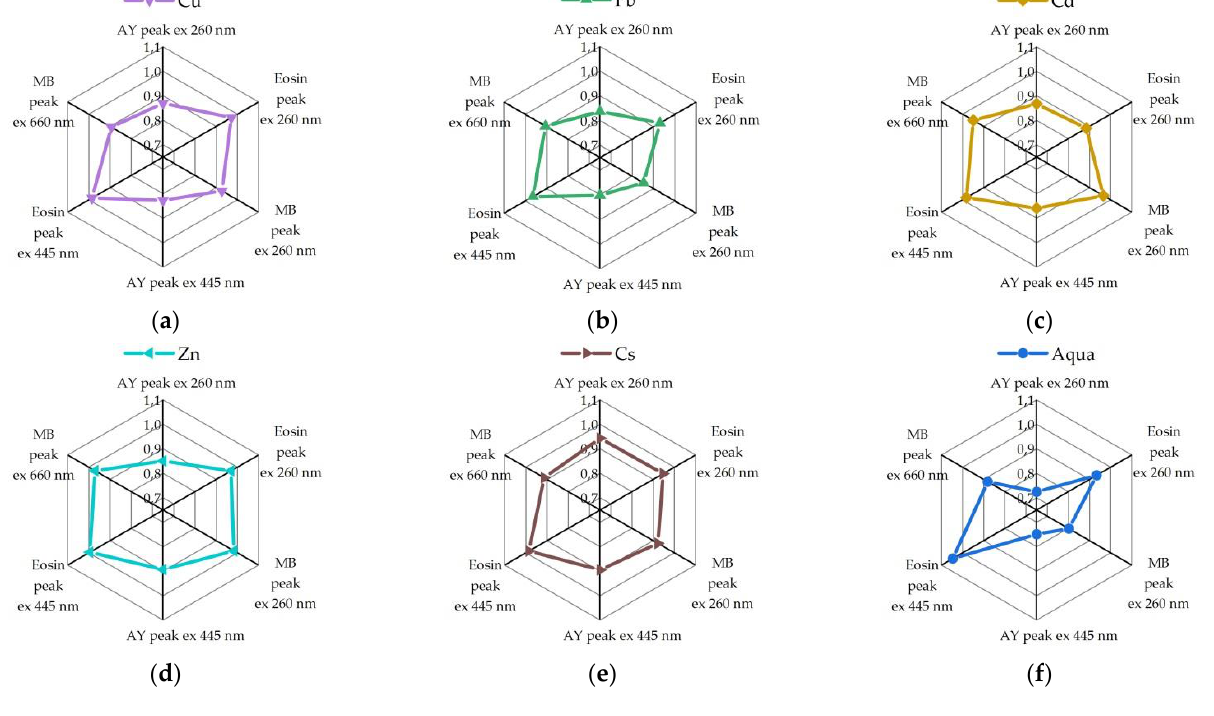
Figure 6. Normalized spectral responses (maxima of fluorescence intensities of three dyes upon excitation at 260 nm and at the maximum absorption of each dye) of the fluorescent probe array to various metal ions: ( a ) CuNO 3 (C Cu(NO3)2 = 2.41 × 10 − 6 M), ( b ) PbNO 3 (C Pb(NO3)2 = 2.8 × 10 − 5 M), ( c ) CdNO 3 (C Cd(NO3)2 = 1.17 × 10 − 8 M), ( d ) ZnNO 3 (C Zn(NO3)2 = 1.46 × 10 − 6 M), ( e ) CsCl (C CsCl = 2.11 × 10 − 6 M), ( f ) H 2 O. The pristine fluorescence intensities of the dyes in array are nor- malized to